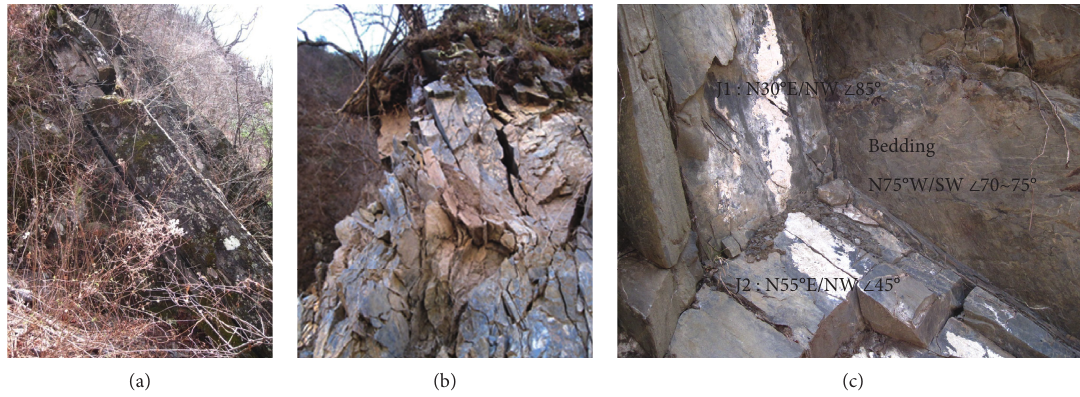
Figure 1: Failure of the natural slopes investigated: (a) sliding, (b) toppling, and (c) wedge failure.